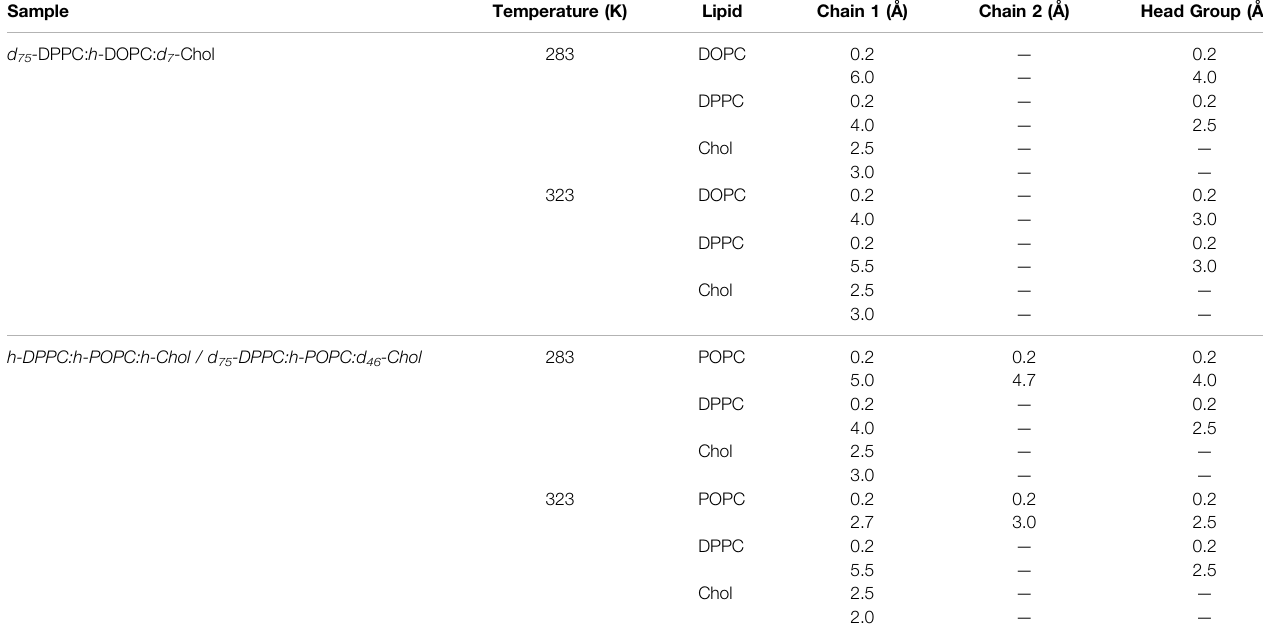
TABLE3| StructuralparametersobtainedfromEISFusing Eqs9 , 10 .Errorsare~10%.Eachcontributionhasbeenweightedforthefractionofmobilehydrogenatomsinthe systemandthenaddedtogether.Thepartiallydeuteratedsamplewas fi rstanalysed,toonlymodelPOPC,andthentheseparameterswereconstrainedinthecaseofthe fully protiated sample to best describe DPPC and cholesterol.